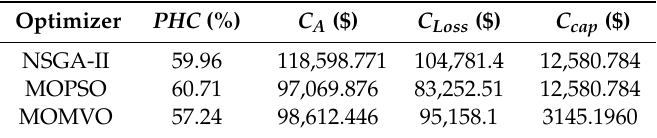
Table 11. Probabilistic results for the 83-node distribution system.